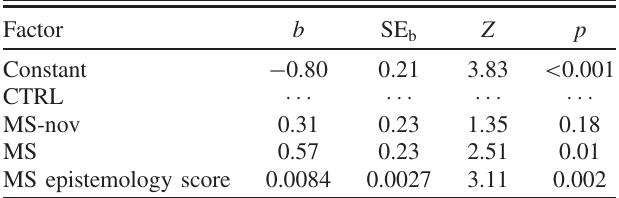
ASSESSING MATHEMATICAL SENSEMAKING TABLE VI. The coefficients of the general linear model with number of crossover approaches used as the dependent variable and instructional group and MS epistemology score as the independent variables.